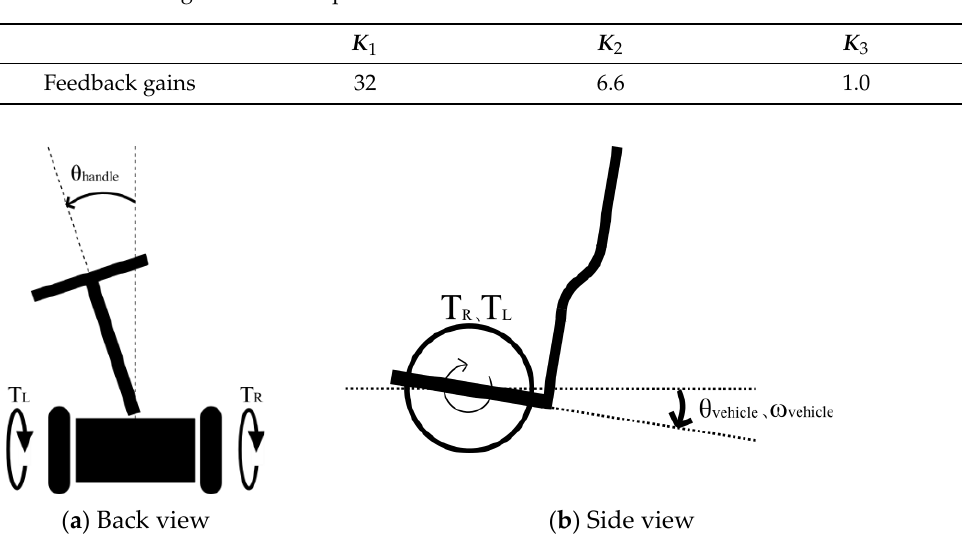
Figure 2. Sign definitions of T R , T L , θ vehicle , ω vehicle , and θ handle . Equations (2) and (3) represent the control equations for manual turning. The two Table 2. Feedback gains for the experiments. wheels had a steering angle of zero, and the vehicle could turn by varying the output of the motors attached to each wheel from left to right. The handle was located at the front center of the vehicle, attached to the step, and a rotation angle sensor was attached to the connection. When the handle was steered, in addition to the straight driving operation, the step tilt angle θ vehicle , angular velocity ω vehicle , and handle angle θ handle were fed back, and the control torque T R was input to the right wheel and T L to the left wheel, thereby stabilizing the control and enabling manual turning. Note that K 1 , K 2 , and K 3 represent the feedback gains defined in Table 2, and T R , T L , θ vehicle , ω vehicle , and θ handle follow the definitions shown in Figure